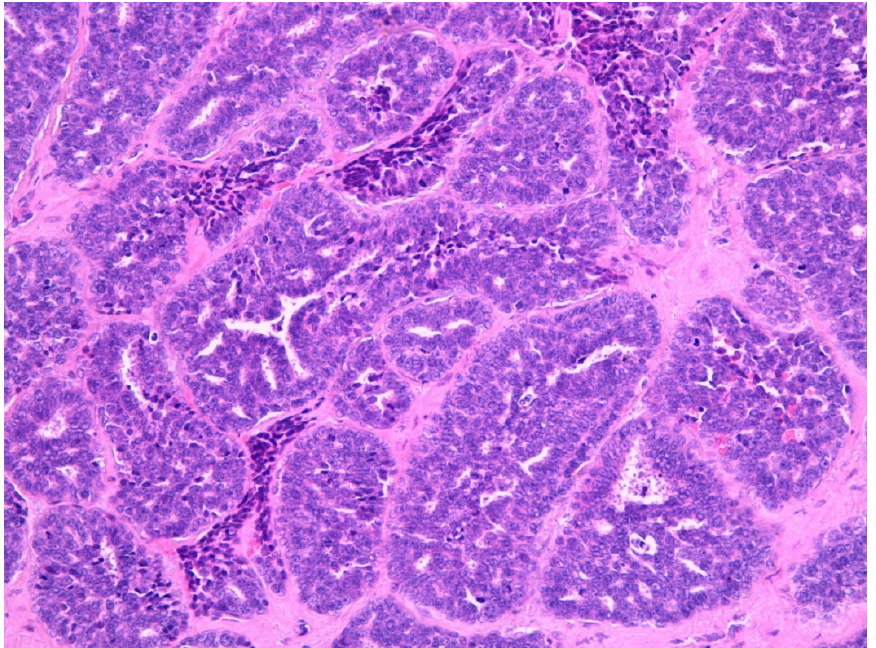
Figure 4 . Adenoid cystic carcinona (40×) stained with hematoxylin-eosin . Figure 4. Adenoid cystic carcinona (40 × ) stained with